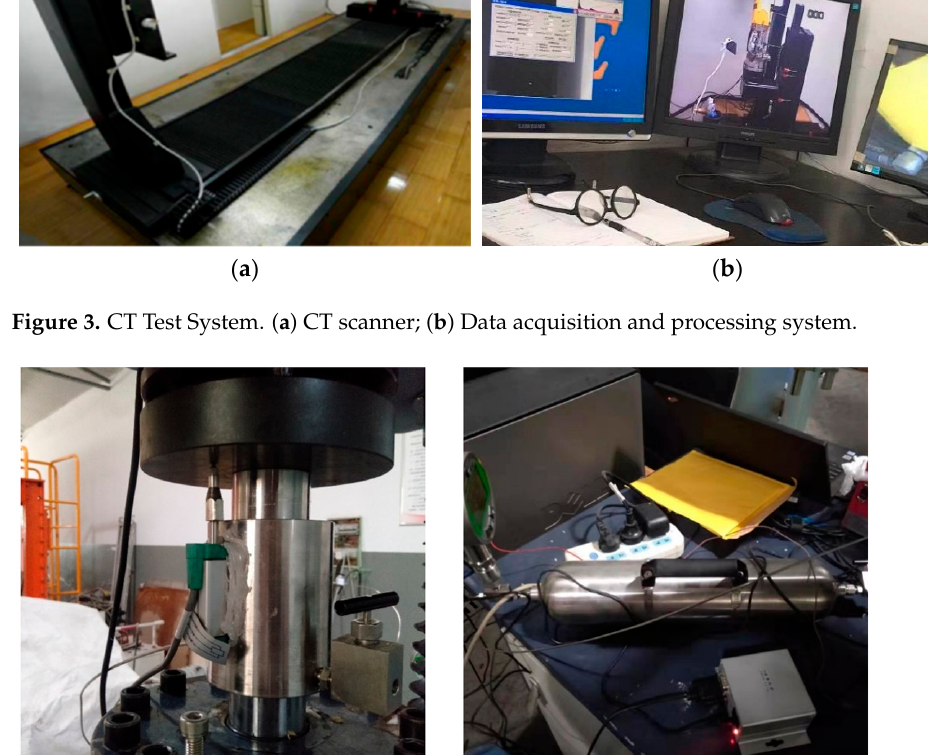
Figure 4. Axial loading system ( a ) Place coal sample; ( b ) Precision pressure valve.